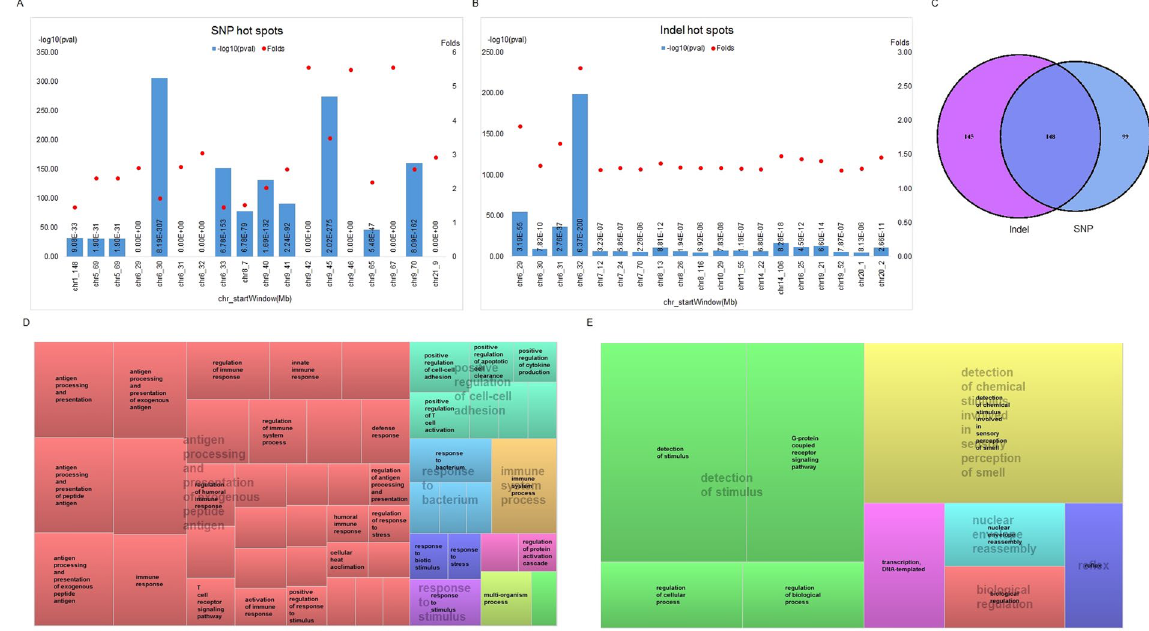
Figure 2. JIA variant hotspots per 1 Mb bin determined with respect to the 1000 Genomes Project variants. The bar shows Fisher exact test p values (-log10) of variant hotspots, and red dots show fold enrichment for each hotspot for ( A ) SNPs and ( B ) indels. ( C ) Venn diagram showing associated genes (overlapped or located within 5 kb upstream and downstream of hotspots) with SNP and indel hotspots. The 247 genes associated with SNP hotspots (of which 148 genes also associated with indel hotspots) were used for Gene Ontology (GO) enrichment analysis. The resulting GO term classifications are depicted using REVigo treemap in ( D ). GO enrichment analysis was also performed with 145 genes from indel hotspots. Results are shown in the GO term clustering represented by REVigo treemap in ( E ). Each rectangle of treemap indicates a GO terms cluster, sub- clusters (related GO terms) of same color are joined into super-clusters (centralized semi-transparent wordings). Size of rectangle reflects statistical significance p-values of GO terms, larger rectangles with smaller